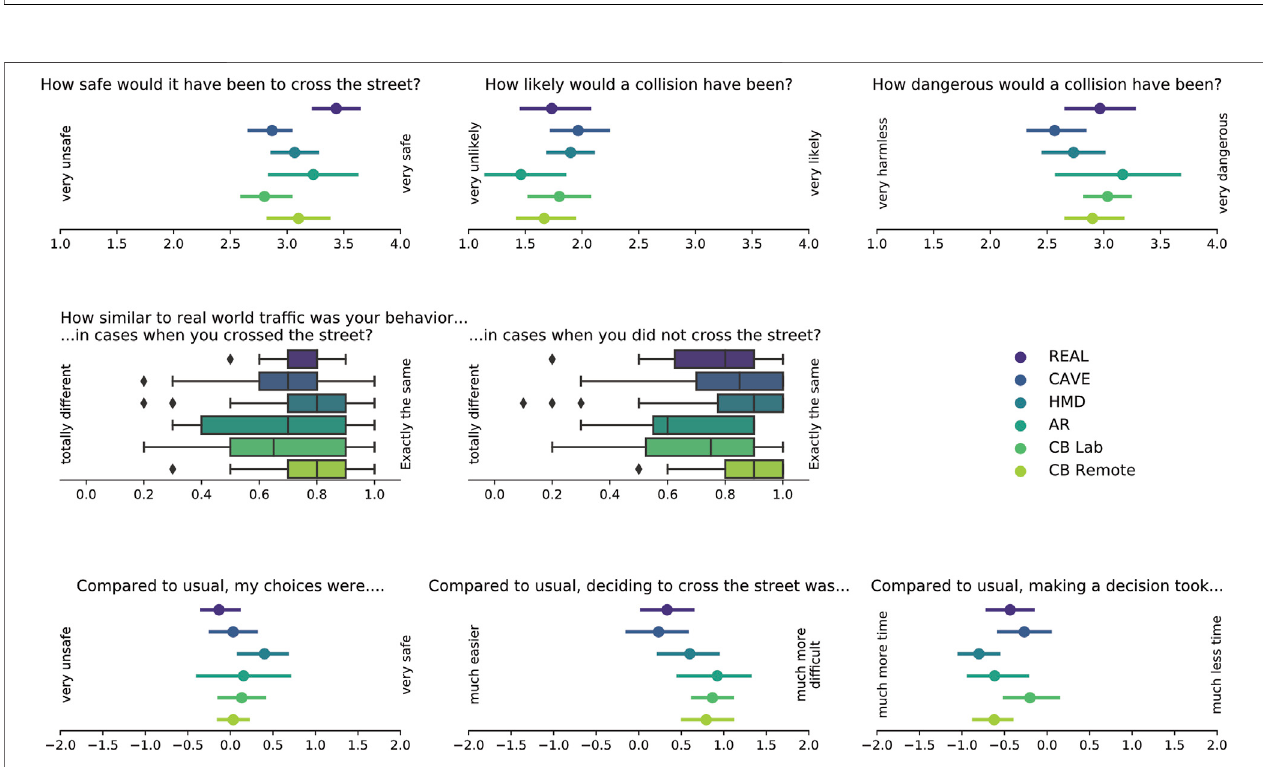
FIGURE 10 | Descriptive data from the questionnaires. Questions with Likert response scales are represented by point plots, questions with continuous response scales by box plots. For the Likert-scaled items, only the most extreme response options are indicated at the edges of the X axis in each case.